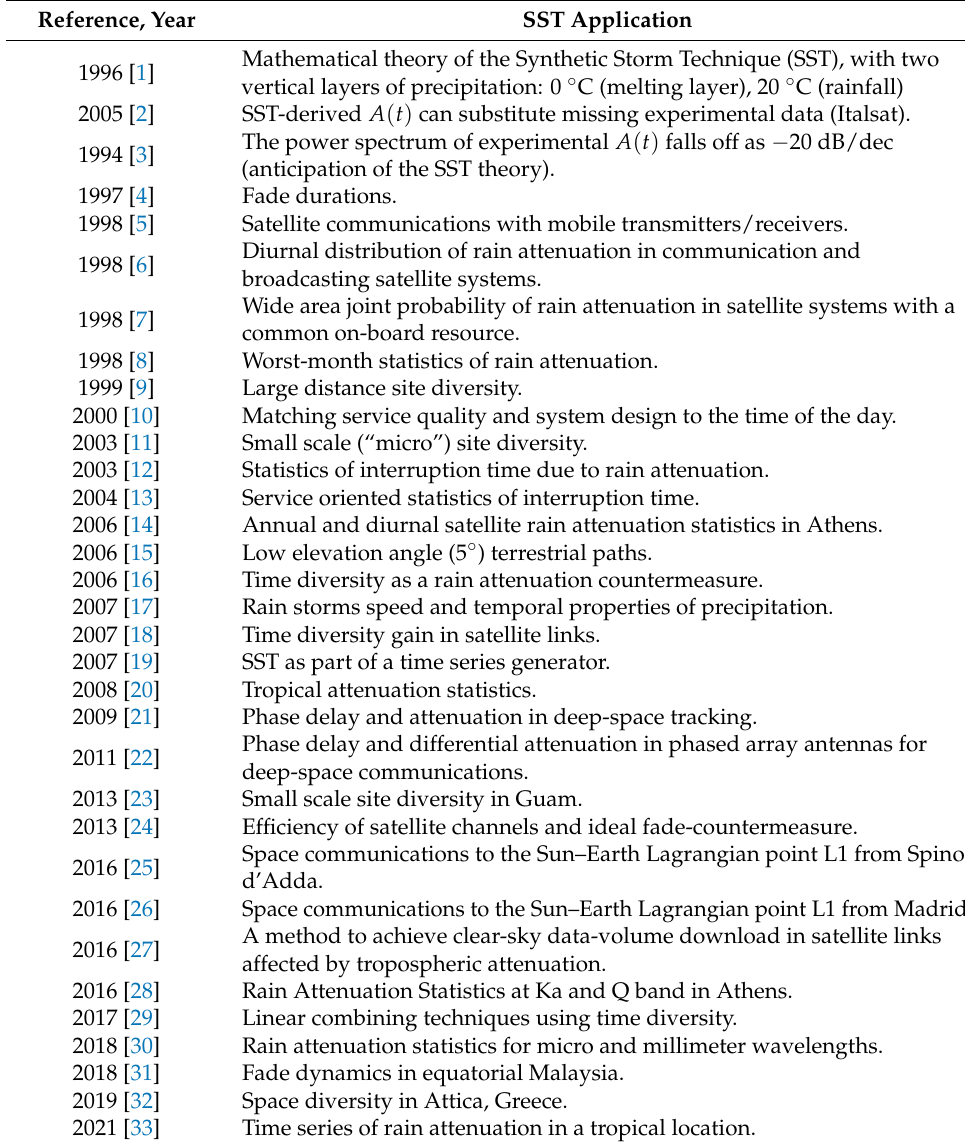
Table 1. References and applications of the Synthetic Storm Technique (SST). Reference, Year SST Application Mathematical theory of the Synthetic Storm Technique (SST), with two 1996 [1] vertical layers of precipitation: 0 ◦ C (melting layer), 20 ◦ C (rainfall) 2005 [2] SST-derived A ( t ) can substitute missing experimental data